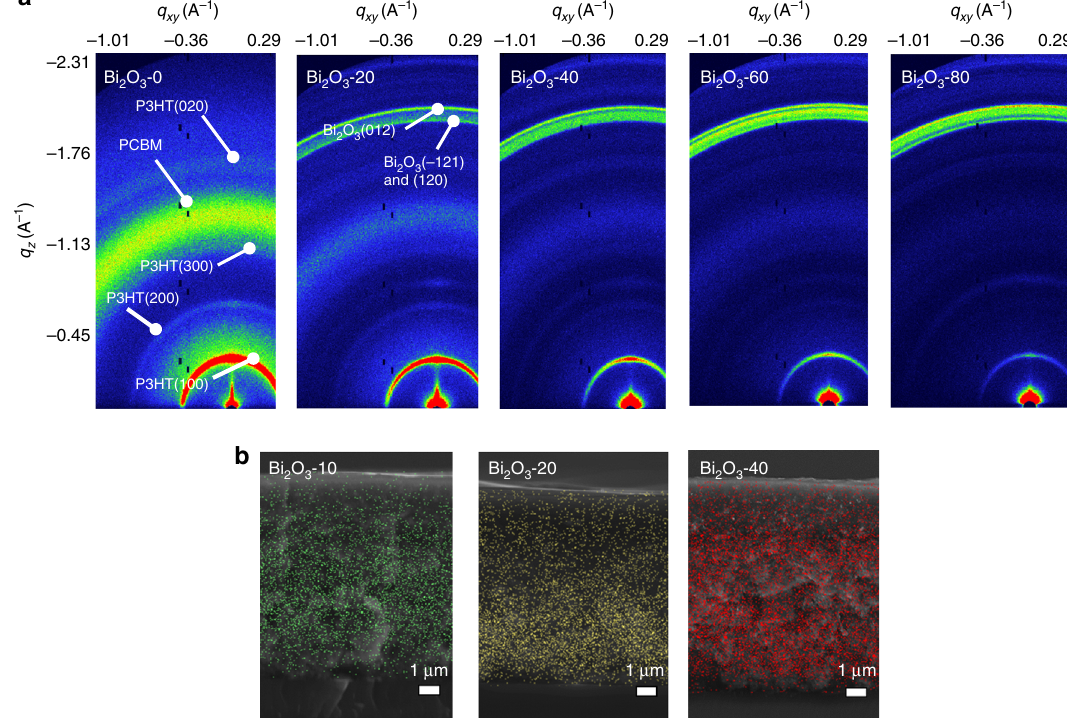
Fig. 4 X-ray detector structural characterisation. a Grazing incidence wide angle X-ray scattering images of Bi 2 O 3 -0, Bi 2 O 3 -20, Bi 2 O 3 -40, Bi 2 O 3 -60 and Bi 2 O 3 -80. Here, the position of the poly(3-hexylthiophene-2,5-diyl) (P3HT), [6,6]-Phenyl C 71 butyric acid methyl ester (PCBM) and bismuth oxide (Bi 2 O 3 ) resultant peaks are indicated. b Scanning electron microscopy cross sections of Bi 2 O 3 -10, Bi 2 O 3 -20 and Bi 2 O 3 -40 overlaid with energy dispersive X-ray spectroscopy imaging of the Bi 2 O 3 nanoparticles (false coloured for clarity)